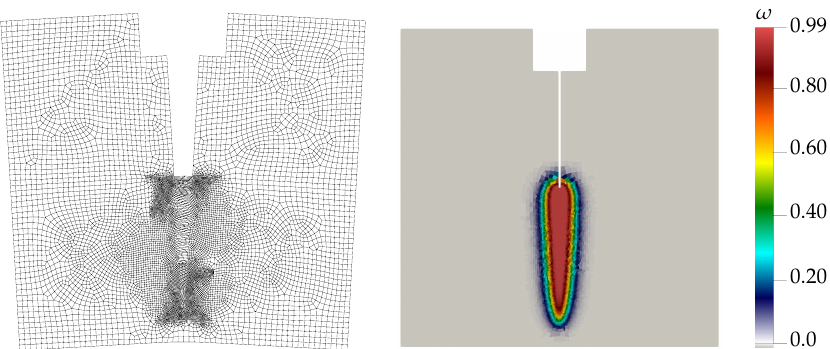
Figure 6. Deformed specimen with a displacement scale factor of 100 ( left ) and distribution of the damage variable ω ( right ) for the unstructured mesh (9504 elements) at a CMOD of